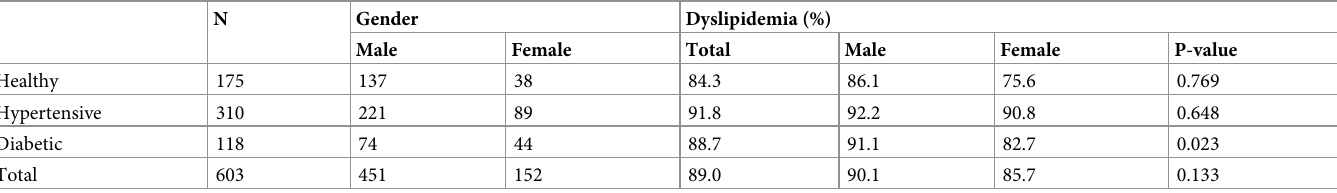
Table 2. Prevalence of dyslipidemia in different groups.